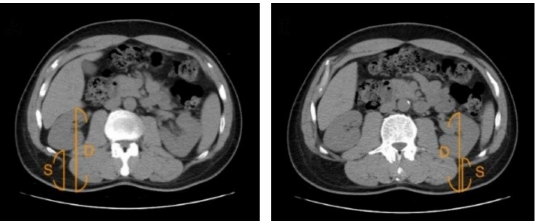
Figure 2. Demonstration of measuring the renal depth via CT image. Two axial slices including the middle of each kidney were collected. The point of deepest (D) and superficial (S) to back body surface were drawn. The renal depth was calculated as (D +